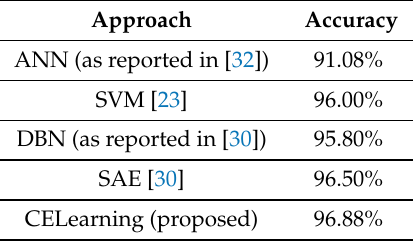
Table 2. Comparison of different methods based on handcrafted feature